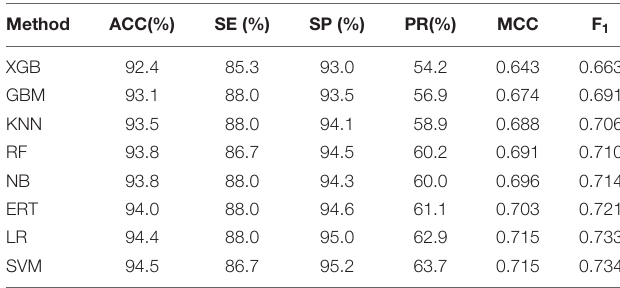
TABLE 3 | Performance comparison of eight types of meta-classifiers in the second stage on the independent dataset Test-850.